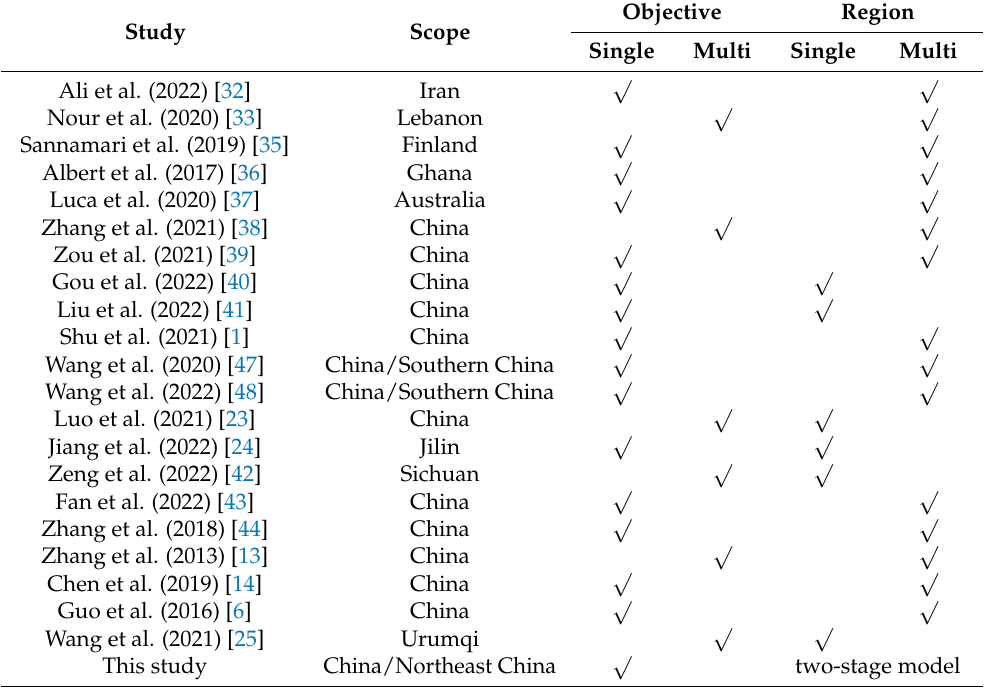
Table 1. Review of power system model studies in recent